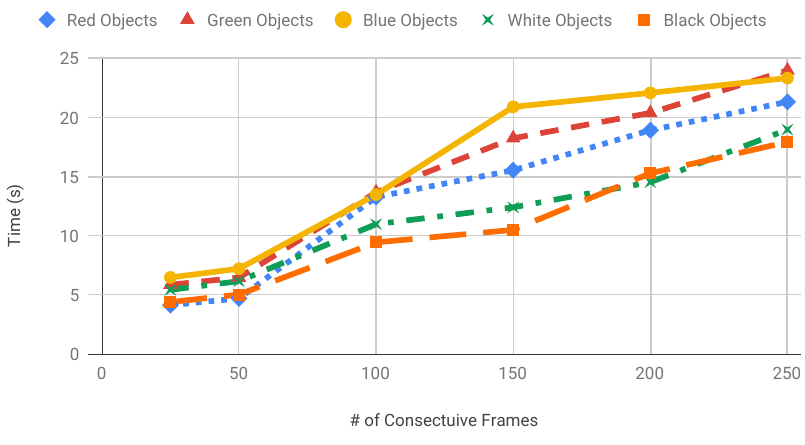
Figure 10. Average object detection time vs. number of